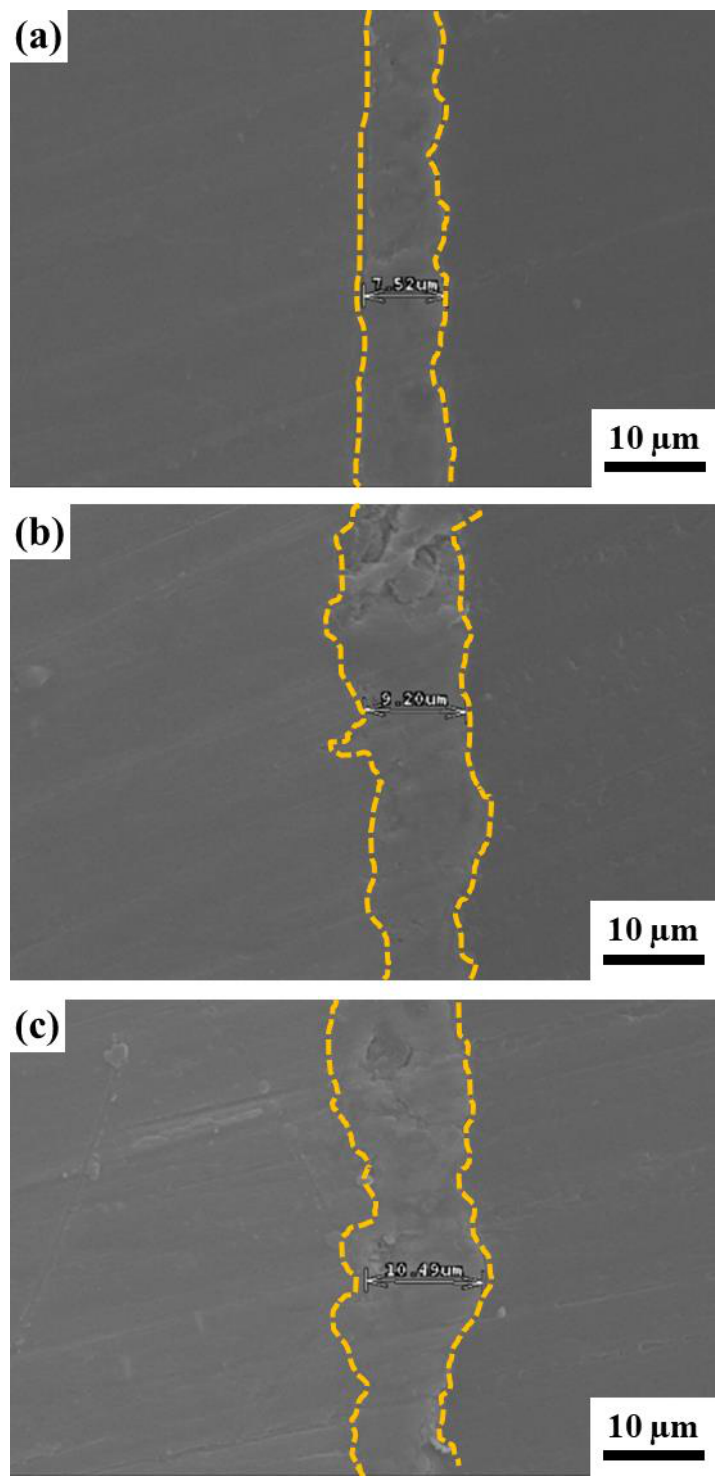
Figure 3. Cross-section SEM morphology of the AZ31 sample treated in the EDTA ( a ) 2.5 g, ( b ) 5.0 g, and ( c ) 7.5 g